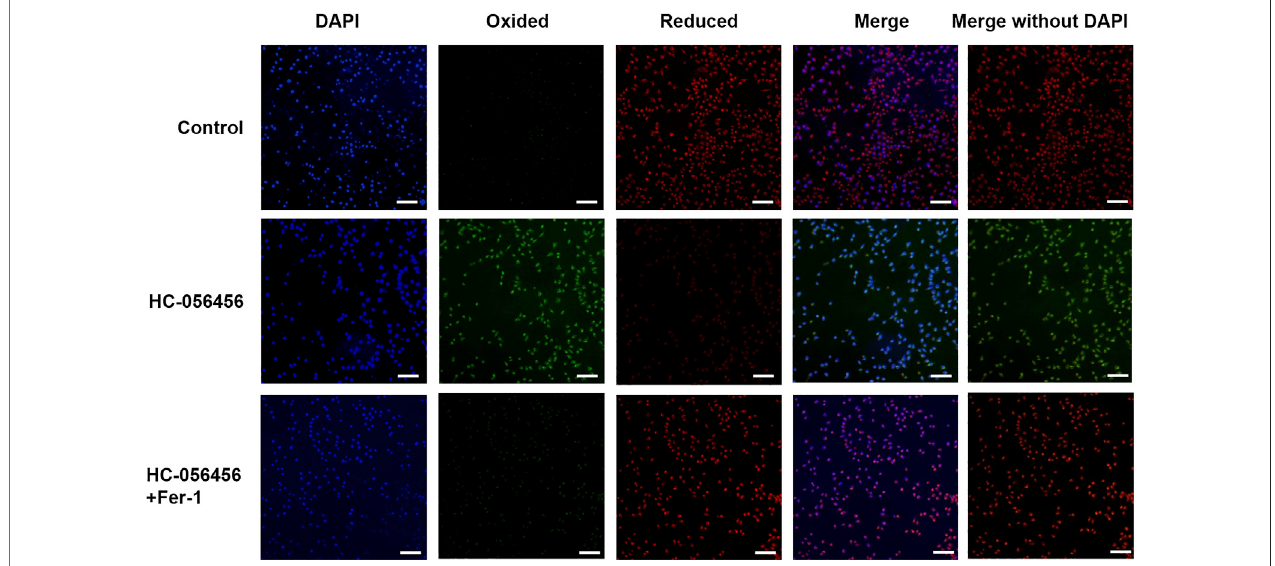
FIGURE 4 | HC-056456 induced lipid peroxidation accumulation in MGC-803 cells. MGC-803 cells were treated with vehicle, HC-056456 (4 μ M) or HC-056456 (4 μ M)incombinationwithFer-1(2 μ M)independentlyfor24 h.ThelipidperoxidationwasrecordedbyprobeC11-BODIPY581/591.Thephotographwascapturedbya fl uorescence microscope (Scale bar = 50 μ m).